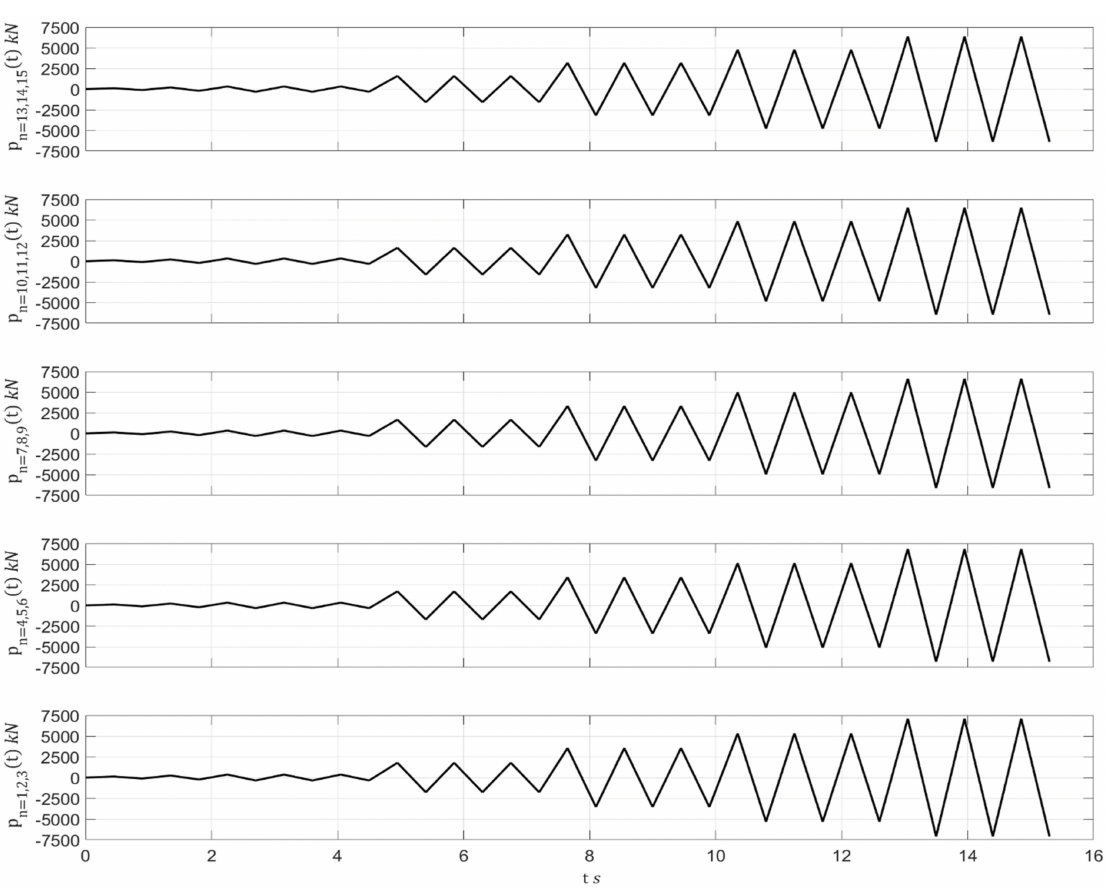
Figure 13. Example 2 quasi-static cyclic